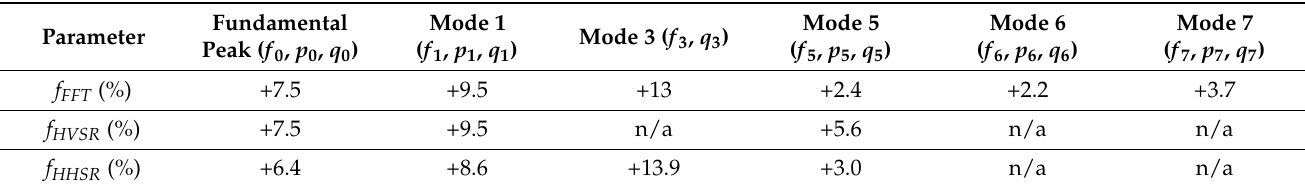
Table 2. Cumulated changes (in %) in spectral peaks throughout the bolting works (comparison between before works and after injection i 2 ). n/a: not spotted by HVSR